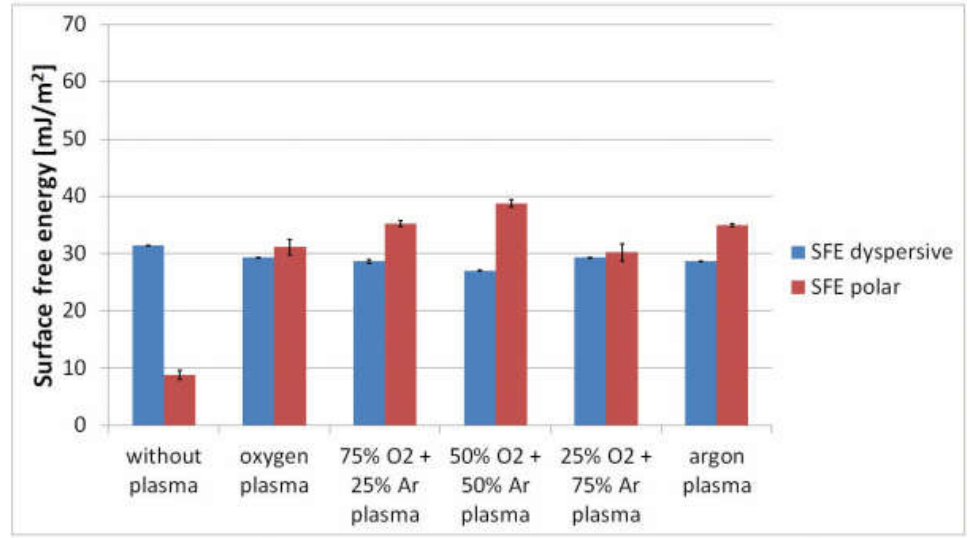
Figure 5. Values of surface free energy and its polar and dispersive components for unmodified and plasma-modified PLA film using different gas compositions.